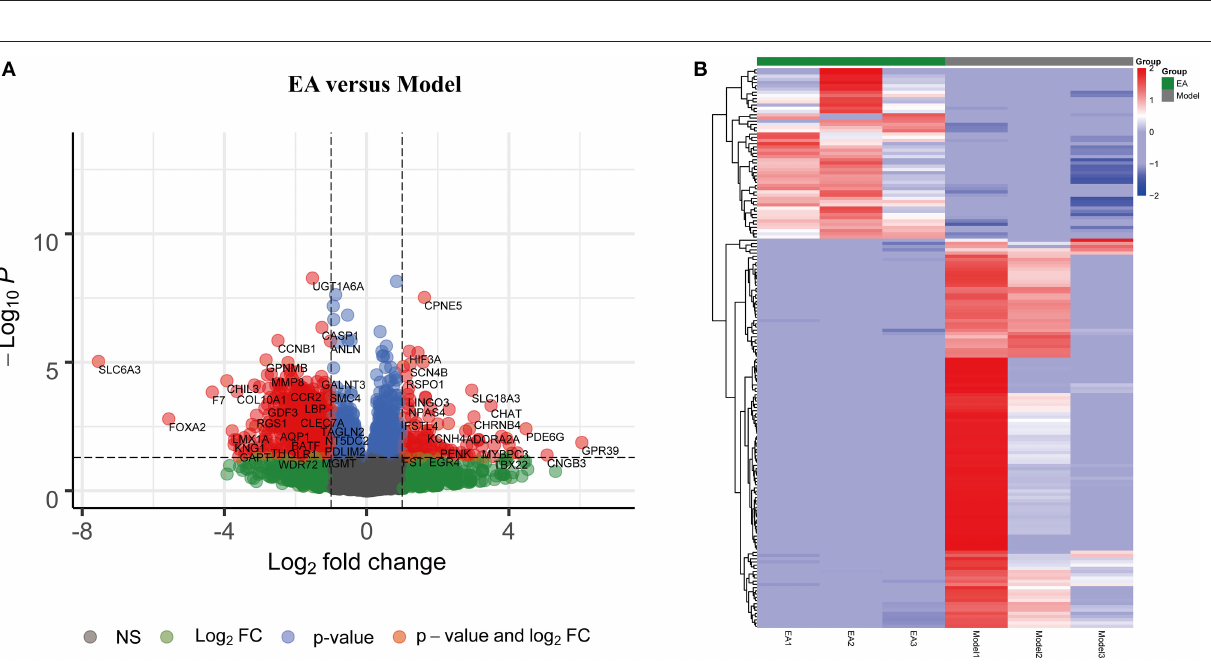
FIGURE 1 | taken for the mice to notice the stickers on their forepaws among the three groups after 7 days of EA treatment ( n = 6 mice/group). (D) The time taken to remove adhesive stickers among the three groups before MCAO surgery ( n = 6 mice/group). (E) The time taken to remove adhesive stickers in the three groups after 7 days of EA treatment ( n = 6 mice/group). (F) The percentage of foot-faults of affected forelimb in each group before MCAO surgery ( n = 6 mice/group). (G) The percentage of foot-faults of affected forelimb in each group at 7 days post-surgery ( n = 6 mice/group). (H) Representative NeuN stained sections from MCAO + EA